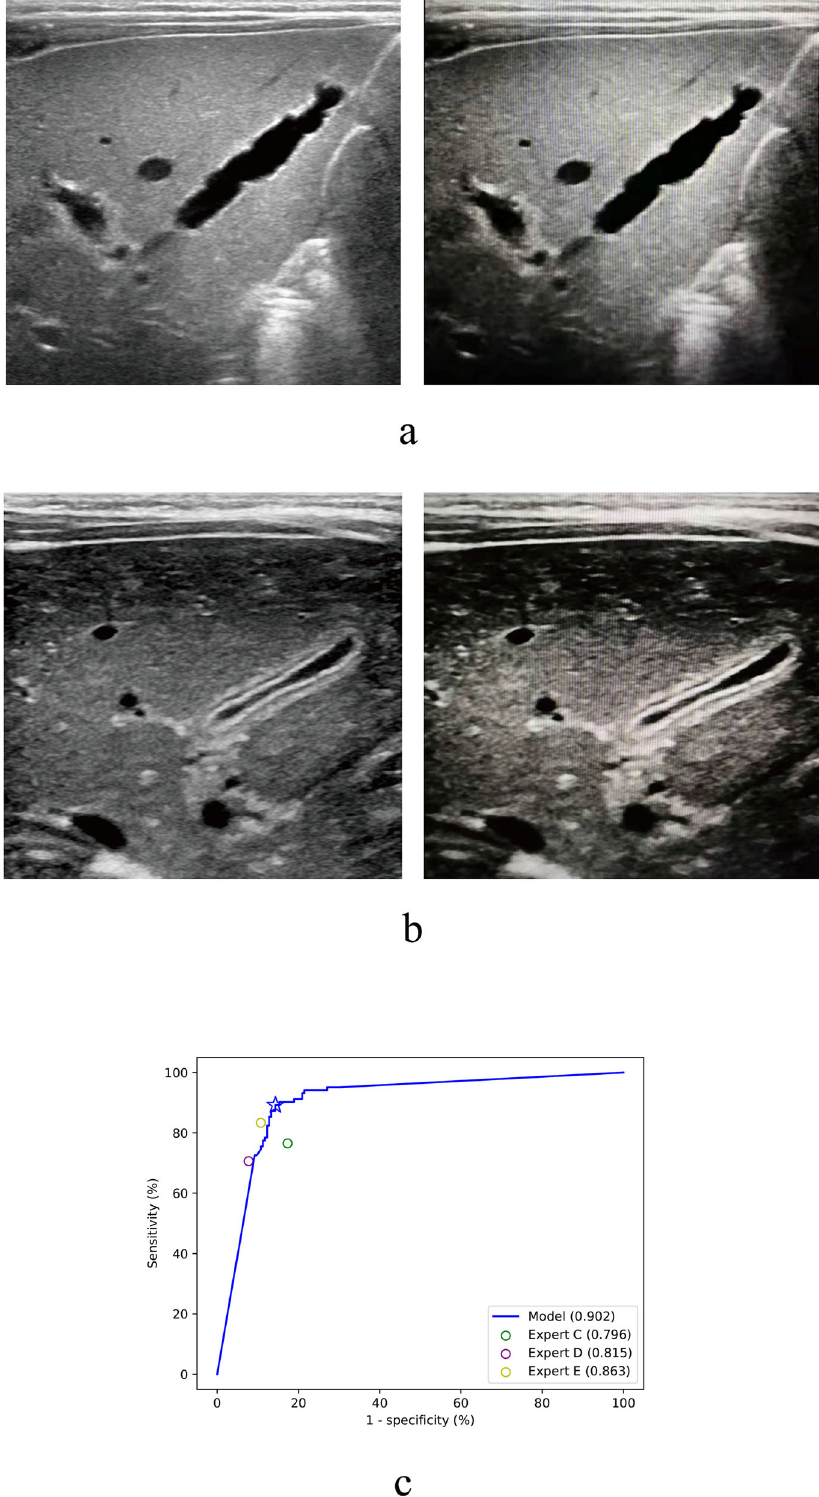
Fig. 3 Diagnosis based on smartphone photos of sonographic images by the deep learning model. a An exemplar original image from a patient with biliary atresia (left) and the smartphone photo of the image (right). b An exemplar original image from a patient without biliary atresia (left) and the smartphone photo of the image (right). c The receiver operating characteristic curve of the model for the diagnosis of biliary atresia on the smartphone images of external validation dataset, with three human experts ’ performances on the original clean external validation dataset for comparison. Source data are provided as a Source data fi